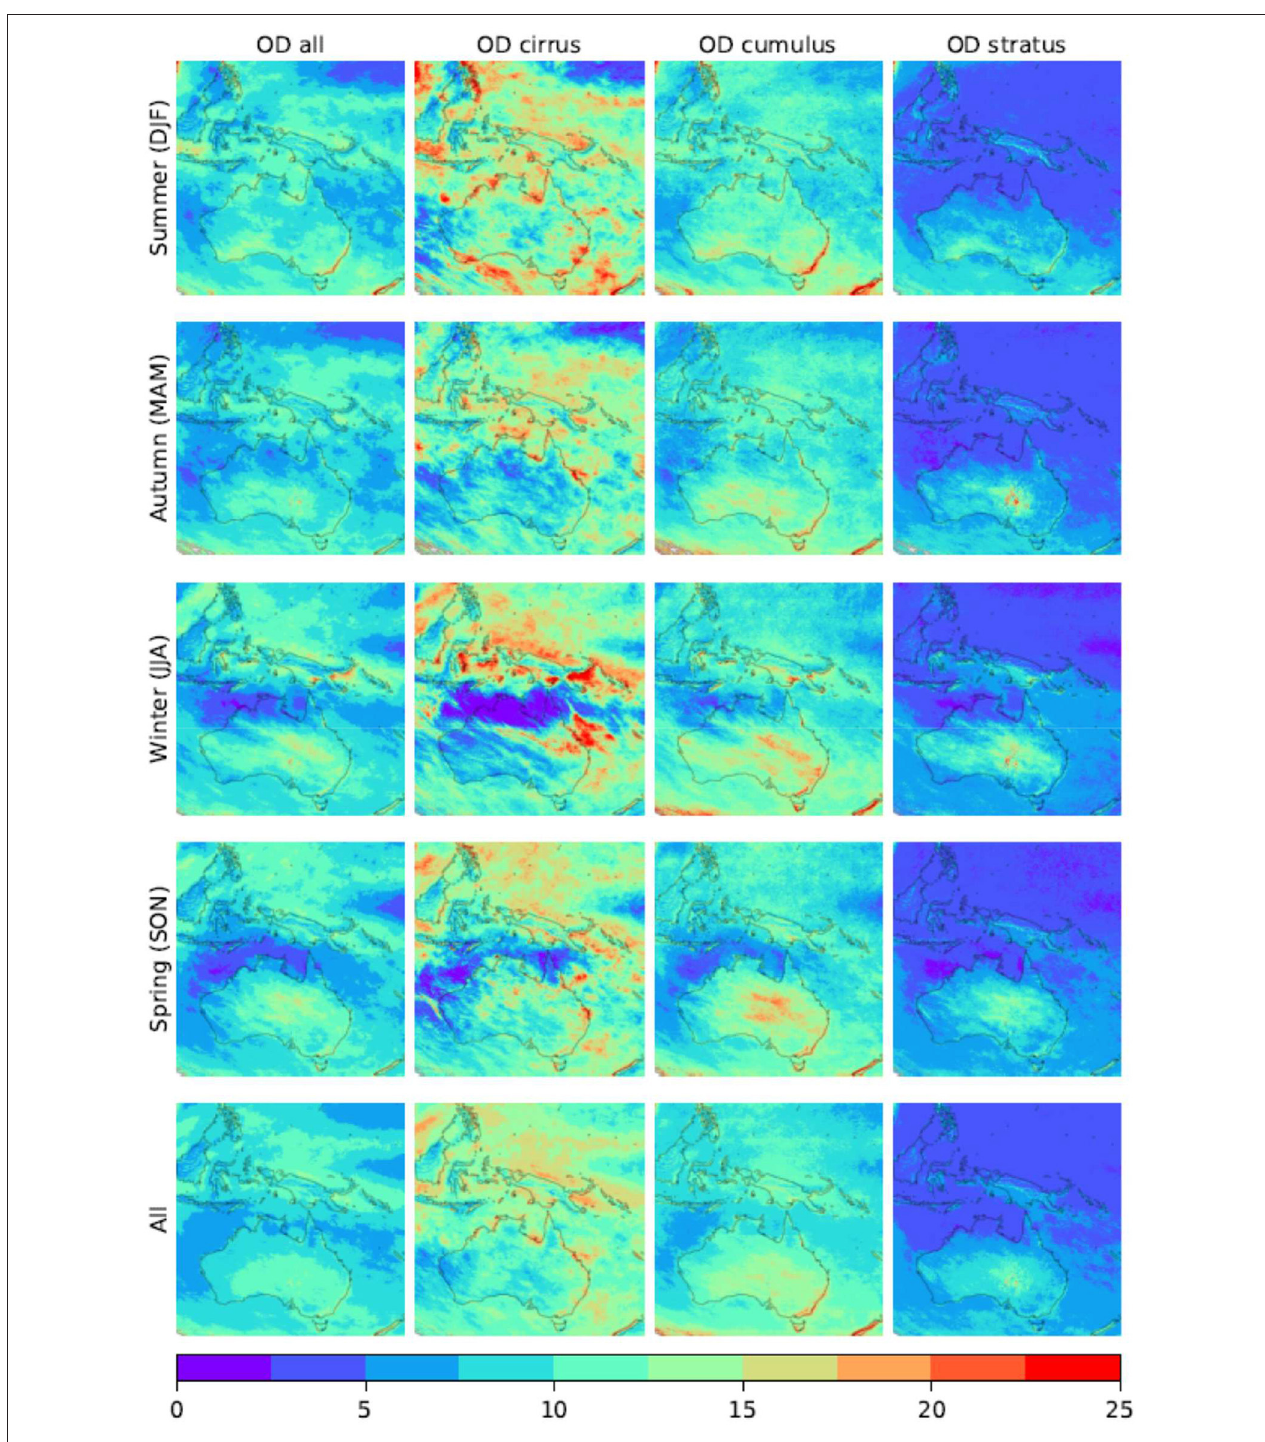
FIGURE 16 | The left-most column (denoted column 1 here) shows cloud optical depth for the all cloud types with columns 2–4 (from left to right) show the optical depth of the broad cloud types. The austral seasons are provided in rows 1–4 and the yearly mean is given in row 5. Data obtained for the period from 1 Jan 2016 to 30 Nov 2017 for daylight hours from 22UTC to 8UTC (8–18 Australian east standard time).